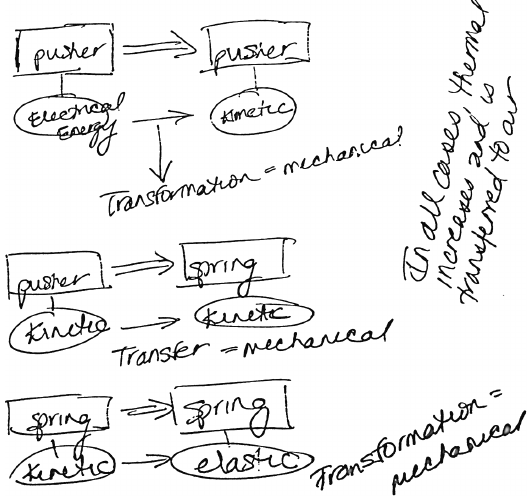
FIG. 7. A learner-invented “ energy source and receiver ” dia- gram for a spring compression